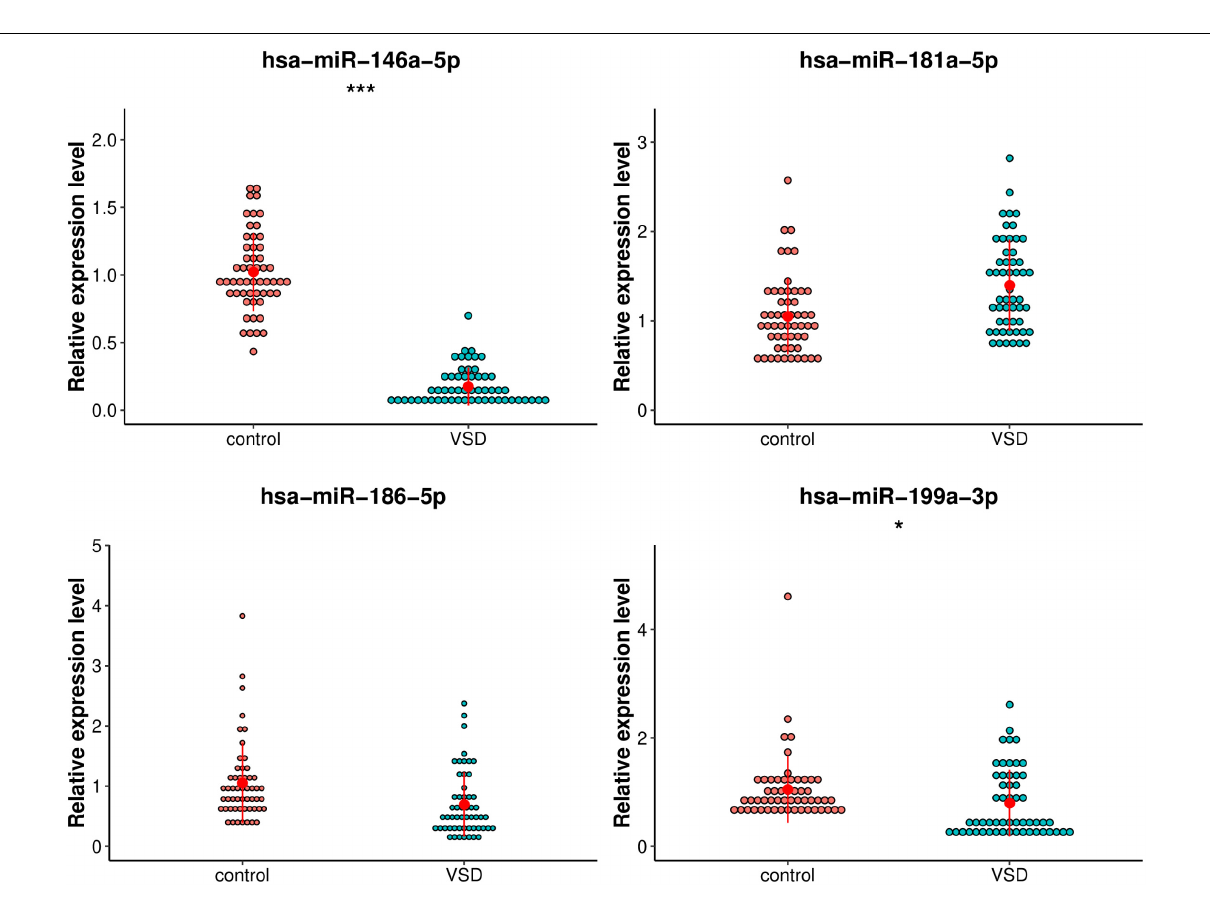
FIGURE 4 | Comparison of the relative expression levels of exosomal hsa-miR-199a-3p, hsa-miR-146a-5p, hsa-miR-181a-5p, and hsa-miR-3158-3p between the VSD and control groups. Independent samples’ t -test indicated that exosomal hsa-miR-146a-5p was significantly downregulated in the VSD group than in the control group ( n = 55 per group), *** p < 0.001; exosomal hsa-miR-199a-3p was significantly downregulated in the VSD group than in the control group ( n = 55 per group), * p <